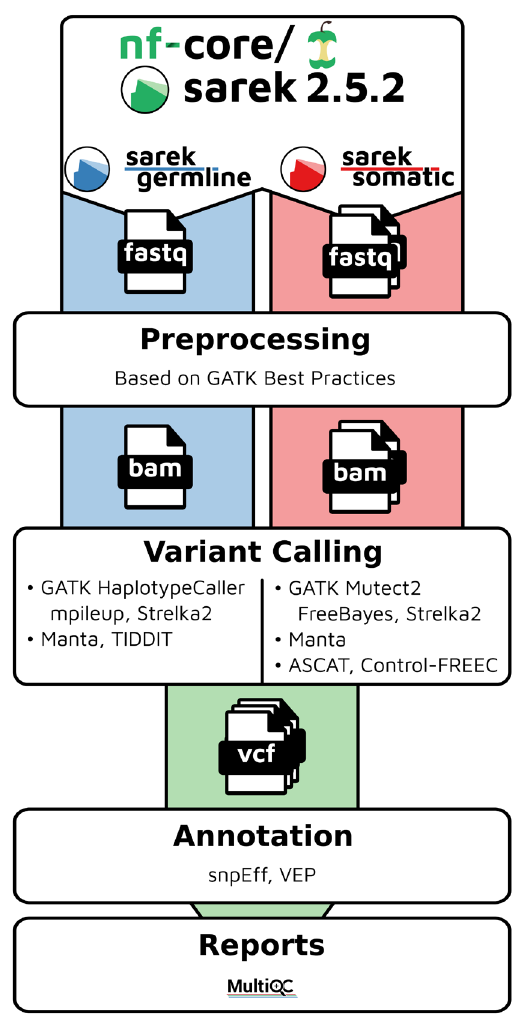
Figure 1. Schematic overview of the Sarek workflow for analysis of germline and somatic variants. A schematic overview including some of the main analysis software implemented in the Sarek workflow. A more comprehensive list of the currently implemented software is given in Table